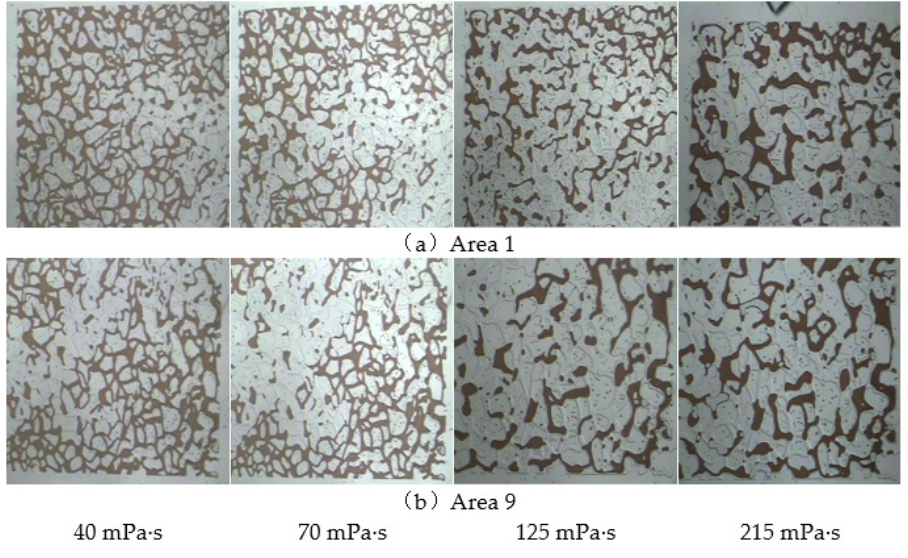
Figure 14. Distribution characteristics of remaining oil in the microscopic unaffected area after polymer flooding. ( a ) Area 1. ( b ) Area 9.